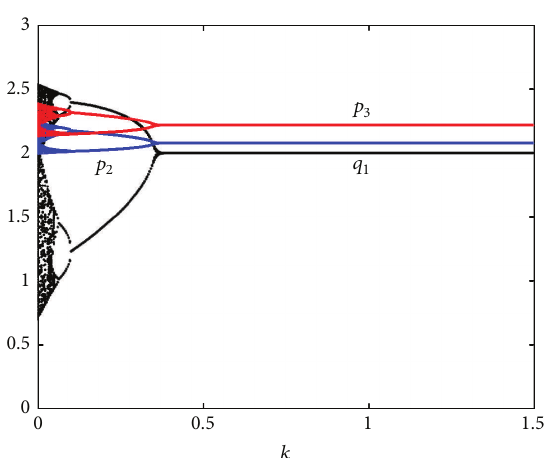
Figure 12: The bifurcation diagram of the controlled system (22) for 𝛽 = 0.15 and 𝛾 = 0.2